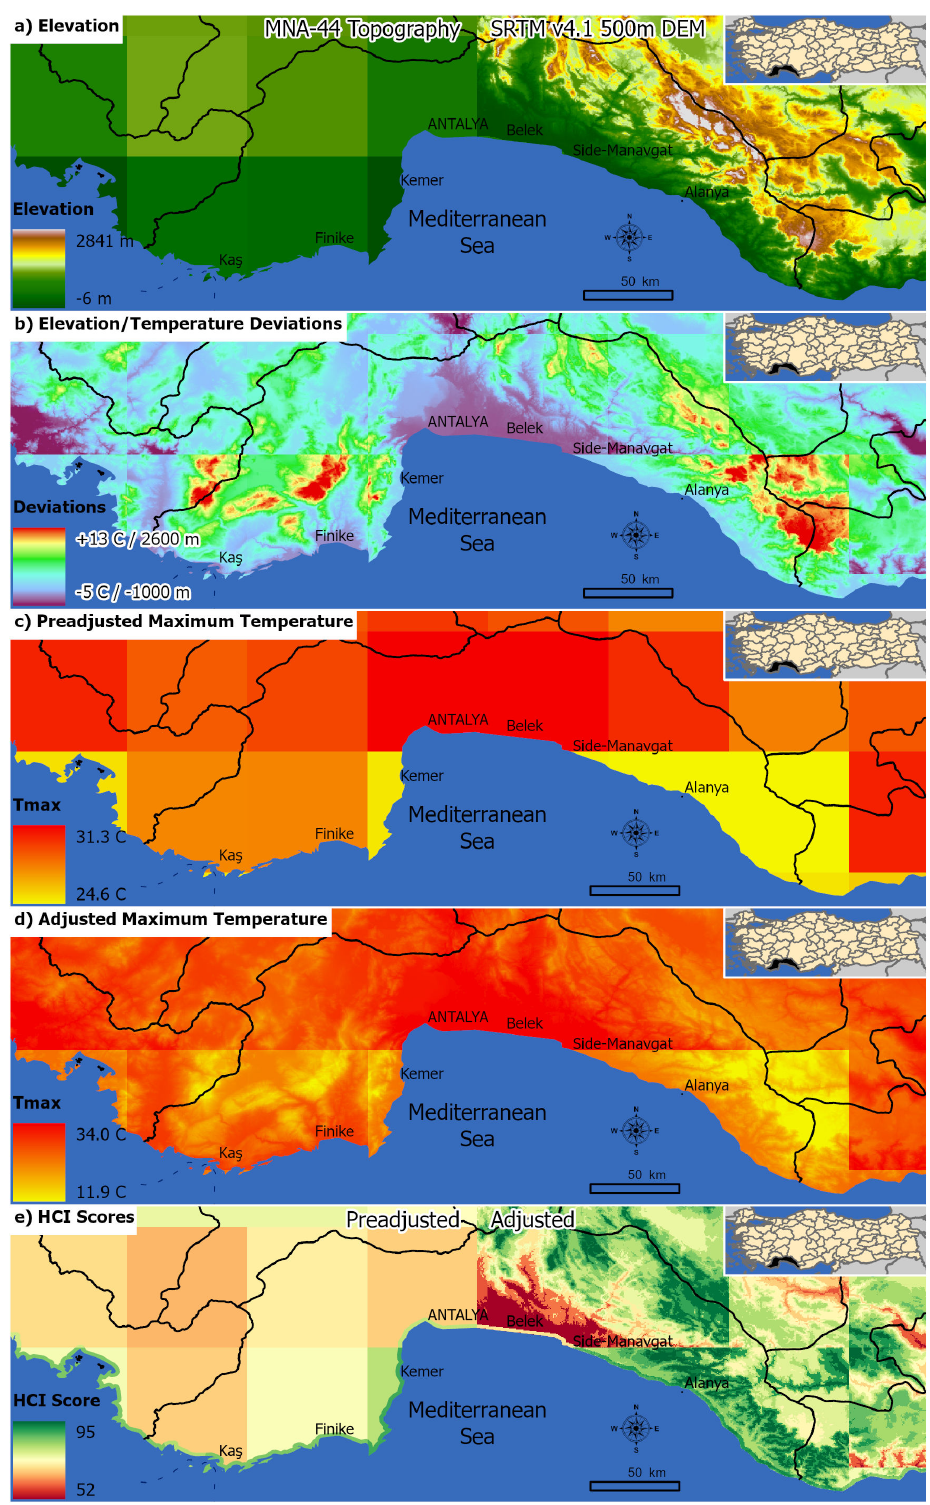
Figure 1. Showcase (Antalya Province, Turkey) of DEM-based lapse rate adjustments on the Summer (1971–2000) maximum temperature outputs. ( a ) MNA-44 Topography vs SRTM v4.1 500 m Elevations ( b ) Elevation/Temperature Deviations ( c ) Preadjusted Maximum Temperature ( d ) Adjusted Maximum Temperature ( e ) MNA-44 Topography vs SRTM v4.1 500 m HCI